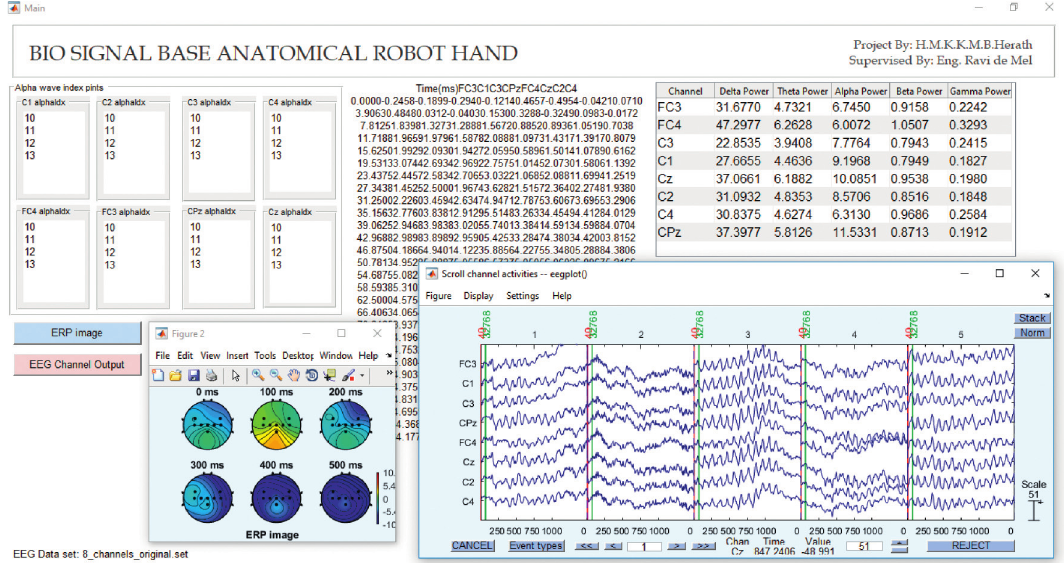
Figure 4: The EEGDAI platform with signal acquisition, preprocessing, and ERP image window.